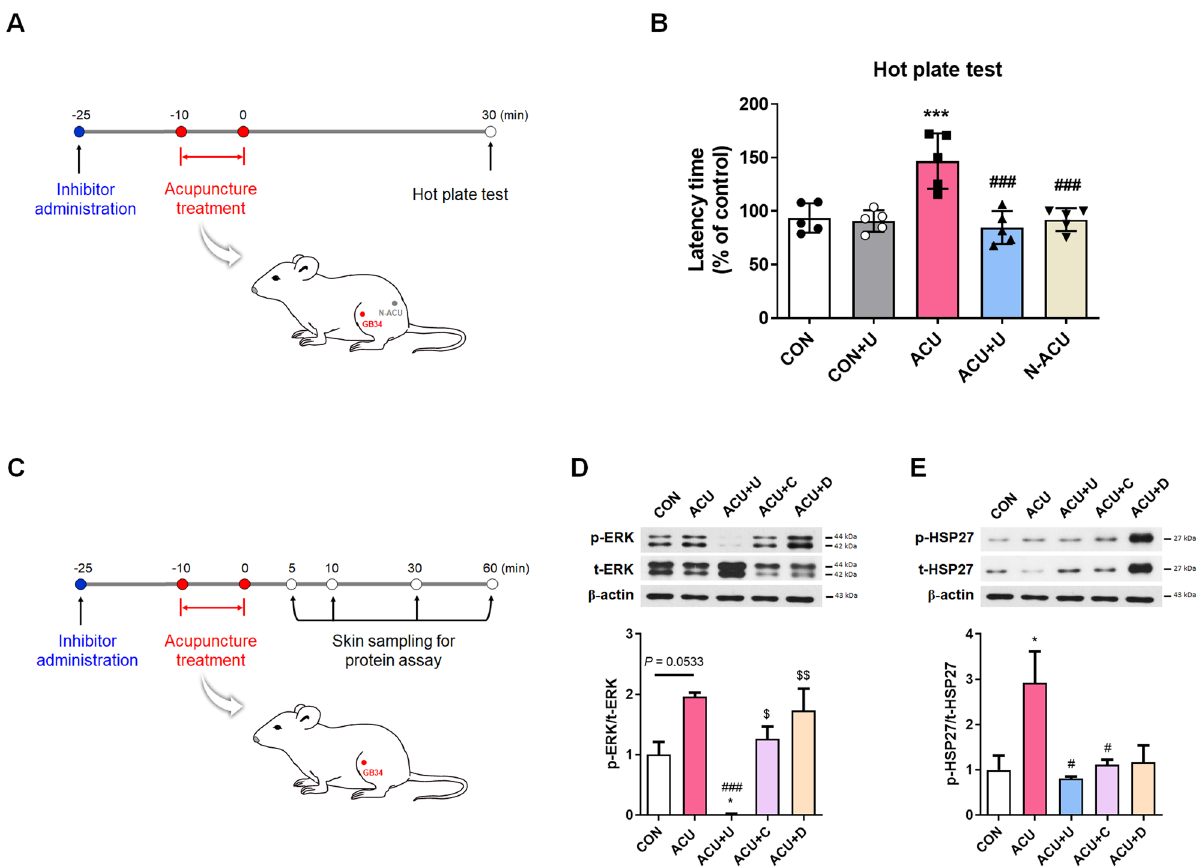
Figure 1. The role of peripheral ERK in the acupuncture-induced thermal pain threshold changes and the acupuncture-induced peripheral molecular signals. ( A , B ) Peripheral administration of U0126, an ERK inhibitor, before acupuncture treatment significantly blocked the effect of acupuncture in increasing the thermal pain threshold (each n = 5). ( C , D ) The activated p-ERK after acupuncture treatment was inhibited by U0126; however, it was not affected by CPZ, a TRPV1 inhibitor and DPCPX, an A1R inhibitor. The activated p-HSP27 were inhibited by U0126, CPZ, and DPCPX (each n = 3). The western blot image represent the cropped blots. Full length blots are presented in Supplementary Figure S2. CON control, CON + U U0126 administration, ACU acupuncture treatment, ACU + U U0126 administration followed by acupuncture treatment, ACU + C CPZ administration followed by acupuncture treatment, ACU + D DPCPX administration followed by acupuncture treatment, N-ACU acupuncture treatment at non-acupoint on the hips. * P < 0.05, *** P < 0.001 compared to the CON group, # P < 0.05, ### P < 0.001 compared to the ACU group, $ P < 0.05, $$ P < 0.01 compared to the ACU + U group. One-way ANOVA was followed by the Newman–Keuls post-hoc test. Data are expressed as the mean ±